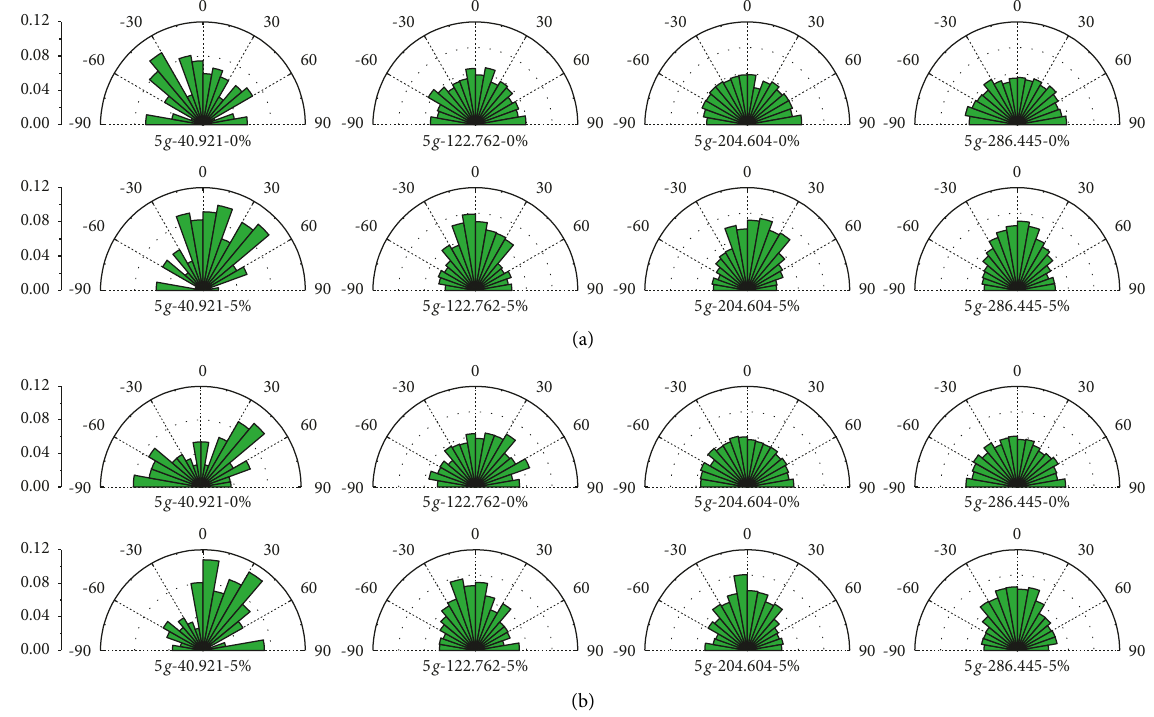
Figure 13: Evolution of orientation degree of void cell in RVEs under 5g gravity. (a) Size effect caused by RVE height. (b) Size effect caused by particle